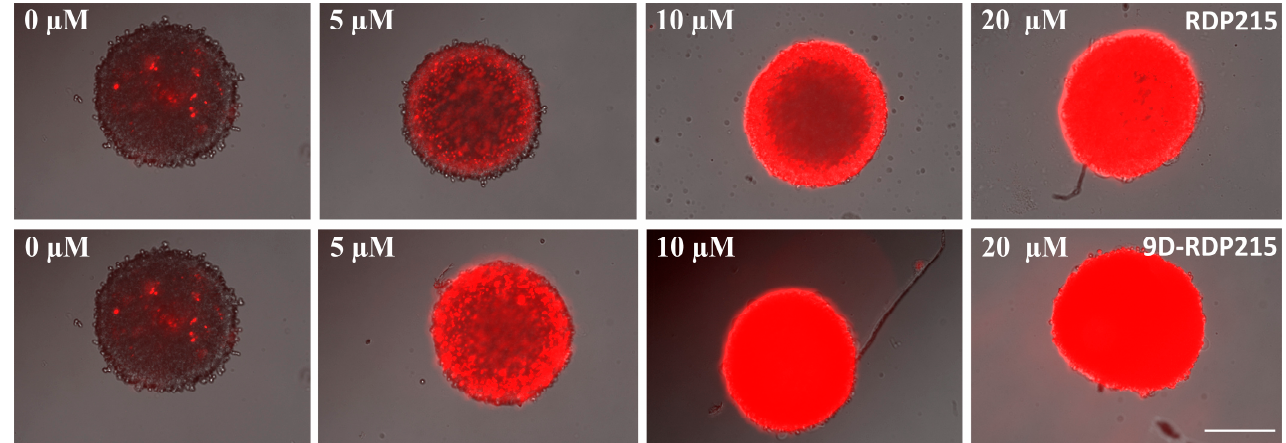
Figure 14. The effect of RDP215 ( top ) and 9D-RDP215 ( bottom ) on LN-229 multicellular tumor spheroids (MCTS) upon 24 h of peptide incubation. Red fluorescence of glioblastoma spheroids by propidium iodide indicates peptide-induced cell death. According to the monolayer experiments, RDP215 causes already high levels of peptide-induced cell death at low concentrations (5 µ m), and its activity rises with increasing peptide concentration. The introduction of D-amino acids within 9D-RDP215 significantly increases peptide toxicity on spheroids of LN-229. Microscopic pictures represent data of at least three independent experiments. The scale bar indicates 250 µ